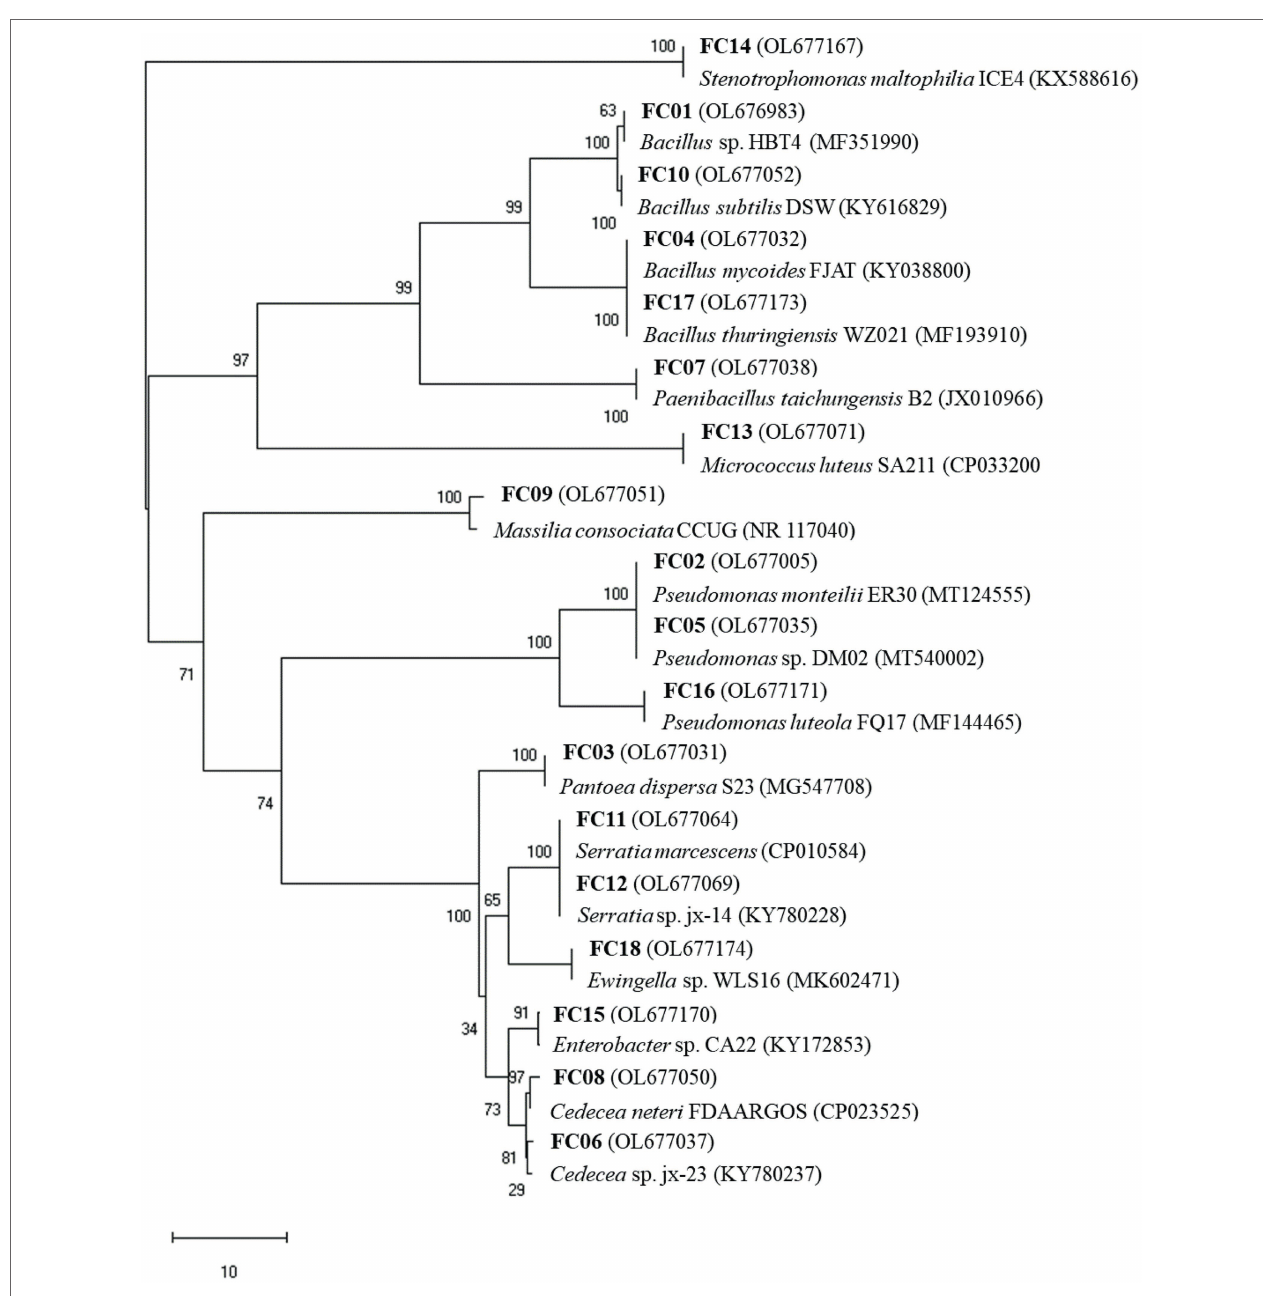
FIGURE 1 | Phylogenetic tree of the 16S rRNA gene sequences of isolates based on the neighbor-joining method. Bootstrap values (1,000 replications) are indicated at tree branching